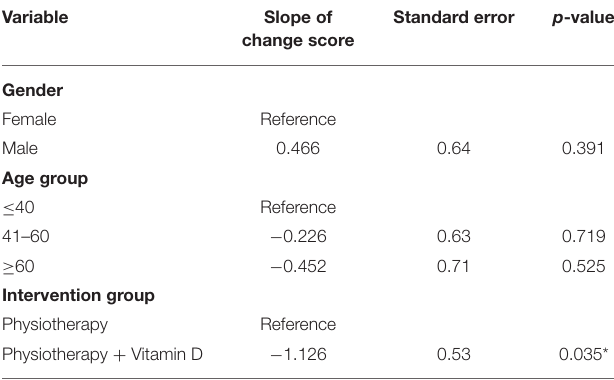
TABLE 3 | Multivariable linear regression analysis on an overall change of pain